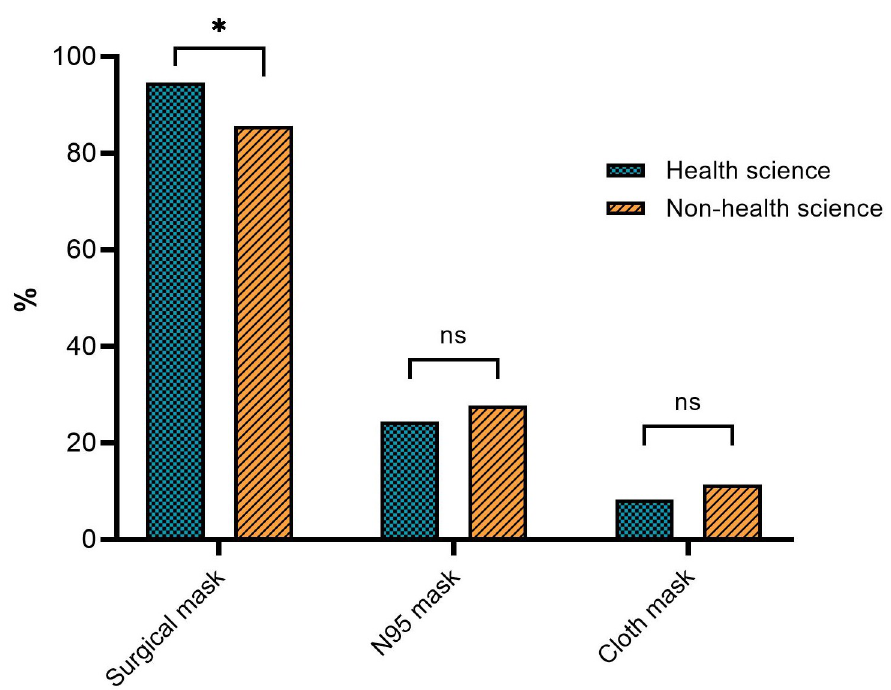
Fig 1. The type of facemasks usage among HS (N = 196) and NHS students (N = 237). * indicates a significant different between HS and NHS students at p < 0.05, while ns indicates no significant.